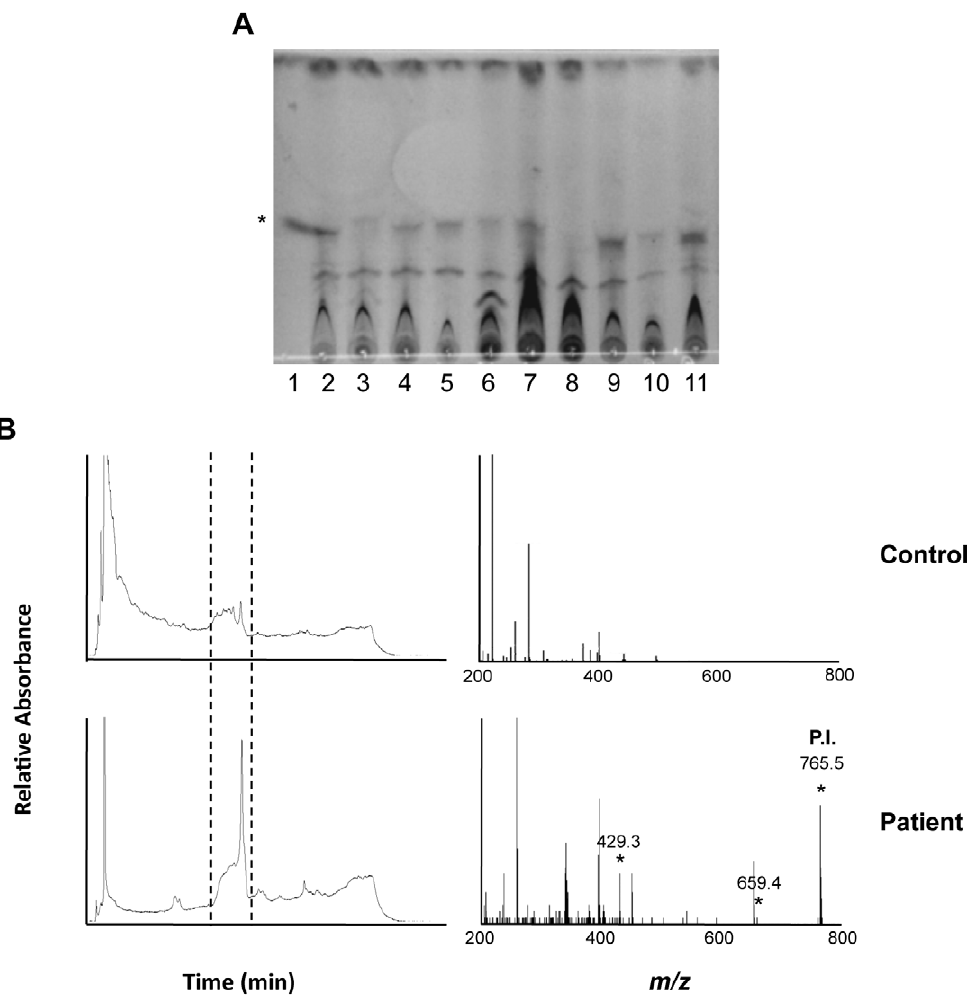
Figure 4. Structurally intact mycolactone is detected in serum samples of BU patients. (A) Example of the fluorescence signals given by serum samples (lanes 2–9), following lipid extraction and analysis by TLC-Fluo. Controls include 1 m g pure mycolactone (lane 1), lipids extracted from a negative serum (lane 10), and then spiked with 1 m g mycolactone (lane 11). The band corresponding to mycolactone is designated by an asterisk. (B) Representative HPLC elution profiles of lipids extracted from serum samples are shown for one healthy control out of 5, and one BU patient among the 4 positive ones. The corresponding MS/MS spectra show the presence of the parent and product ions of mycolactone in this positive sample. Similar results were obtained in a second